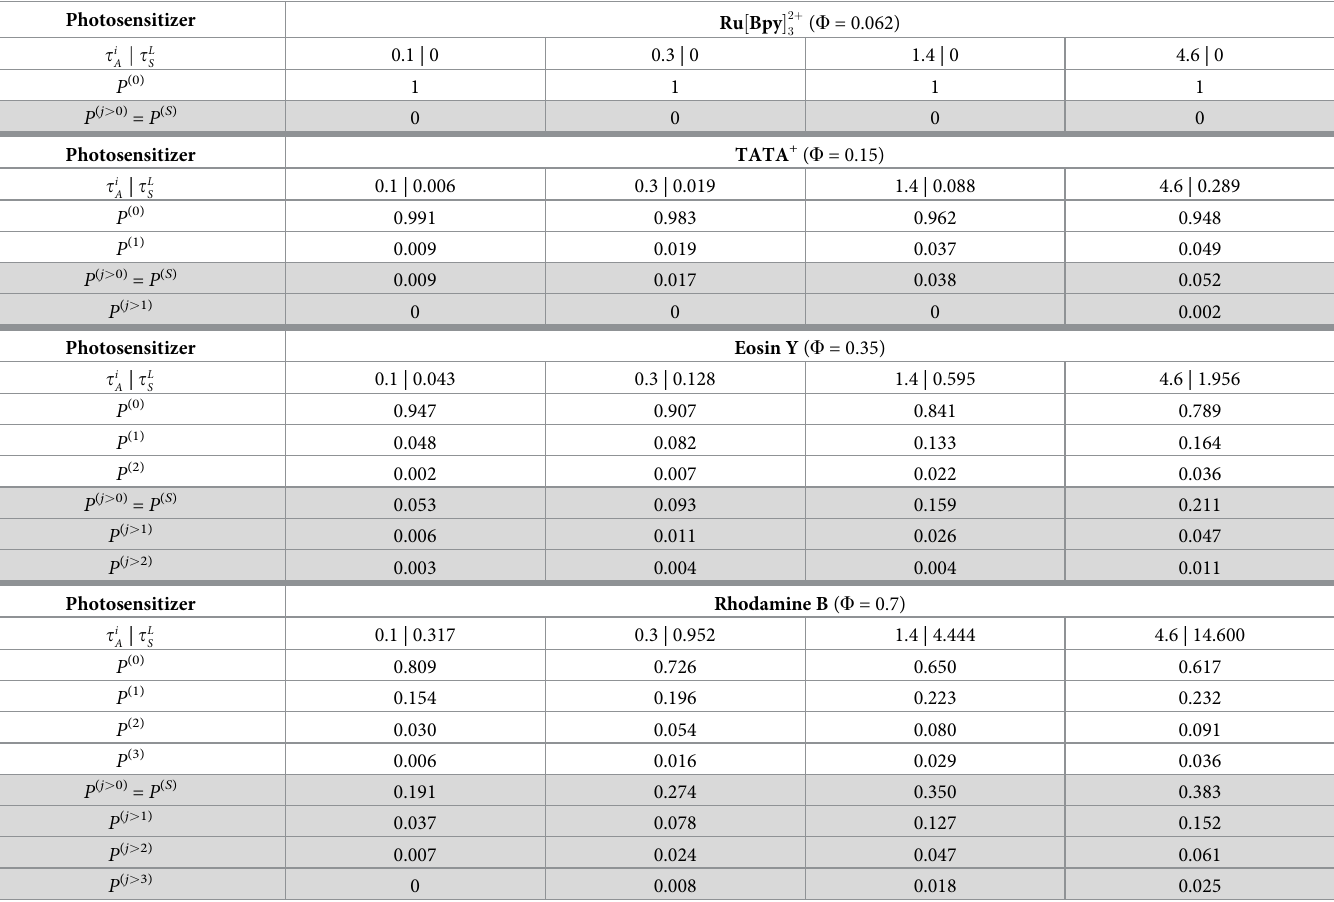
Table 3. Successive orders of scattering for Ru ½ Bpy � 2 þ , TATA + , Eosin Y and Rhodamine B photosynthetizers (radiative properties are presented in Fig 2) at selected 3 and t L (see Eqs 4–7 and Fig 2): distribution P ð j Þ ¼ P ð j Þ = P of scattering orders (or the probability that an absorbed photon is absorbed after optical thicknesses t i A A A S